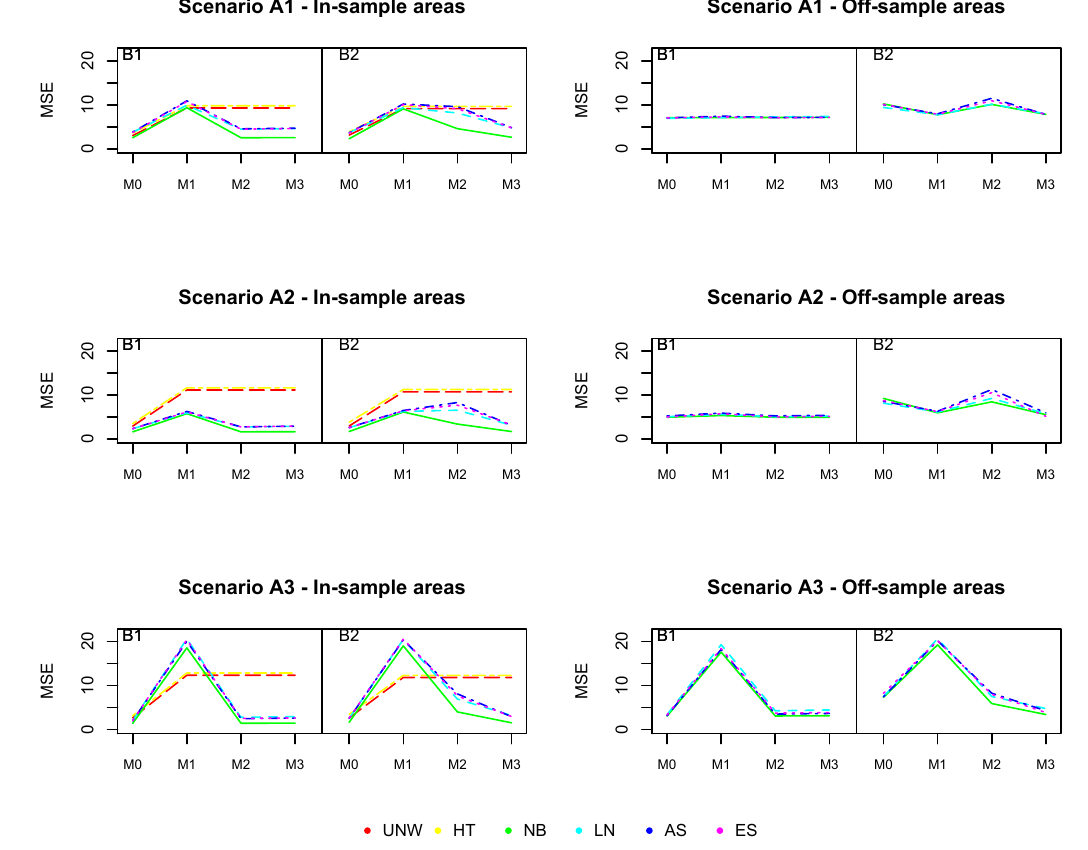
Figure 7. Simulation 2: MSE ( × 10 3 ). UNW = unweighted estimator; HT = Horvitz–Thompson estimator; NB = naive binomial model; LN = logit-normal model; AS = arcsine model; ES = effective sample size model. ( A 1 ) : σ 2 v = 0.15 and σ 2 u = 0.03; ( A 2 ) : σ 2 v = 0.09 and σ 2 u = 0.09; ( A 3 ) : σ 2 v = 0.03